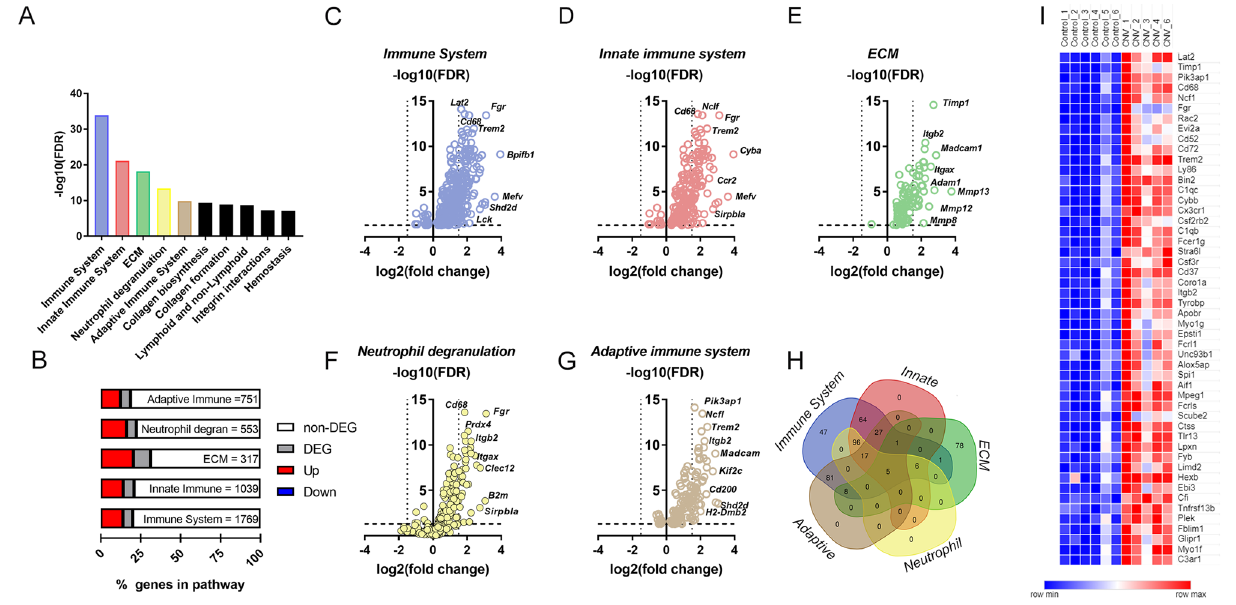
Figure 3. Immune system and extracellular matrix reactome pathways were identified in overrepresentation testing of DEG mouse-CNV genes. ( A ) Bar graph showing the top 10 reactome pathways ranked by statistical significance. x-axis is reactomes ranked by statistical significance (FDR) and y-axis is − log10 FDR. The top five reactomes are further analysed; immune system (blue), innate immune system (red), ECM (green), neutrophil degranulation (yellow), adaptive immune system (brown). ( B ) Bar distribution graph showing that ECM reactome has the highest percentage of DEG expressed compared to the other top five reactomes. x-axis is % of genes in pathway. Legend: non-DEG genes (white), DEG (grey), up regulated DEG (red) and down regulated DEG (blue). ( C ) Volcano plot of immune system reactome genes (blue) that are DEG. x-axis is biological significance (log2FC) and y-axis is statistical significance (− log10 FDR). ( D ) Volcano plot of innate immune system reactome genes (red) that are DEG. ( E ) Volcano plot of ECM genes (green) that are DEG. ( F ) Volcano plot of neutrophil reactome genes (yellow) that are DEG. ( G ) Volcano plot of adaptive immune system reactome genes (brown) that are DEG. ( H ) Venn diagram that overlaps immune system (blue), innate immune system (red), ECM (green), neutrophil degranulation (yellow), adaptive immune system (brown) reactomes to show there is little overlap between ECM and the immune-related pathways. ( I ) Heat map of the upregulated genes in the ECM reactome. x-axis is the samples grouped by control and CNV and y-axis is genes ranked alphabetically. The raw counts for each sample are shaded in pseudo colour with higher counts (red) and lower counts (blue). DEG differentially expressed genes, ECM extracellular matrix, FDR false discovery